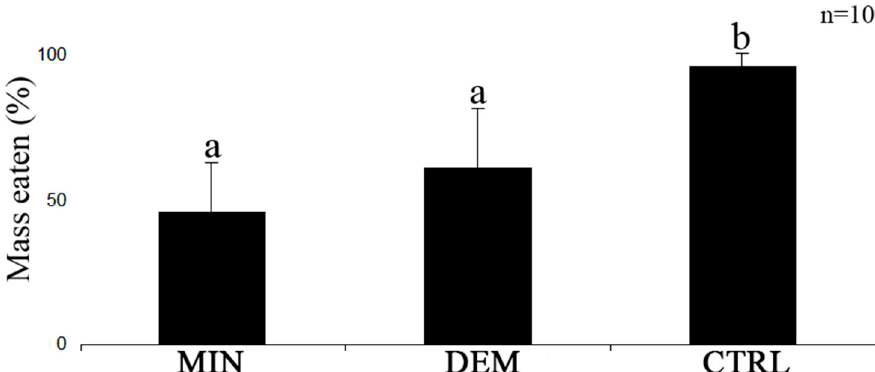
Figure 3. Mean percentage (%) mass eaten of mineralized (MIN) and demineralized (DEM) tissues of P. gymnospora and control (CTRL— U. fasciata ) by L. variegatus . Different letters indicate distinct consumption ( p < 0.05). Values are means and standard deviation of n = 10.